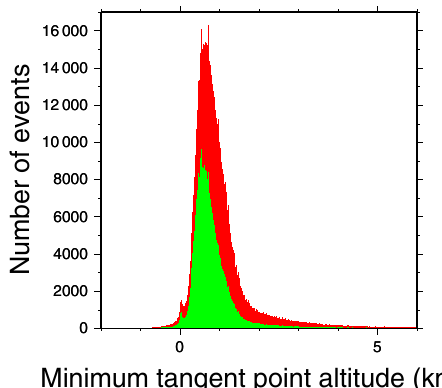
Figure 5. Histogram of the lowest altitude profiled in ocean events that has been flagged as likely reflection (SVM > 0.25, in red) and very likely reflection (SVM > 1, in green).